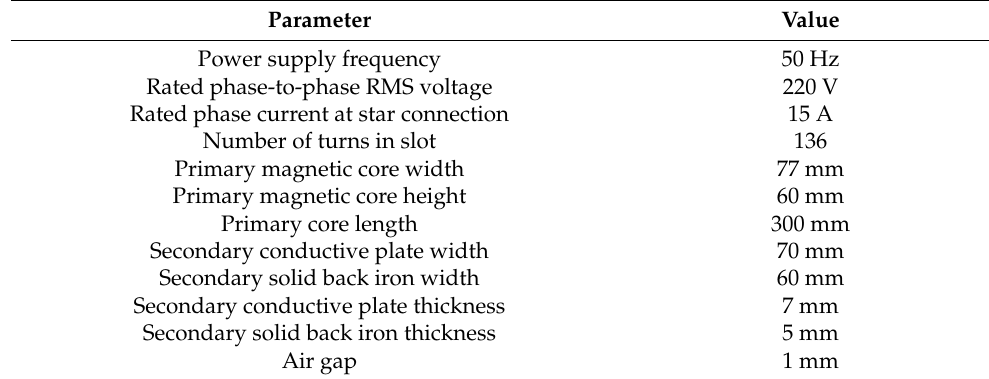
Table 2. Parameters of the LIM experimental unit.